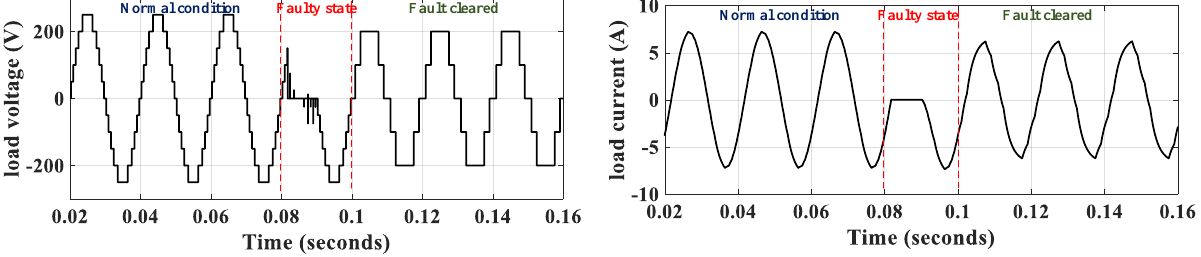
Figure 15. Simulation voltage and current waveforms under S 1 fault.